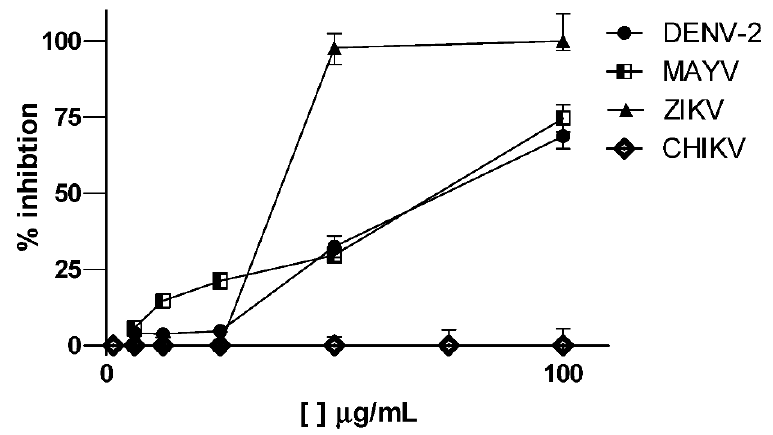
Figure 14. Dose–response curves for antiviral activity of ethanolic extract from Fridericia chica leaves against Dengue (DENV-2), Zika (ZIKV), Mayaro (MAYV) and Chikungunya (CHIKV) viruses.